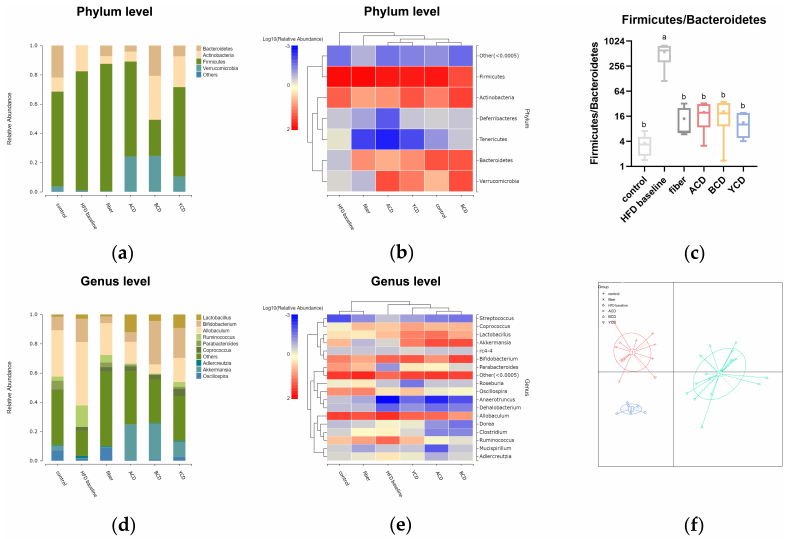
Figure 10. α -CD, β -CD, and γ -CD supplementation altered microbiota compositions. Fecal microbial community ( a , b ) at the phylum level and ( d , e ) at the genus level; ( c ) ratio of relative abundance of Firmicutes to Bacteroidetes; ( f ) enterotype clustering, n = 6. Control, low-fat diet; HFD baseline, high-fat diet without cellulose; fiber, high-fat diet; ACD, high-fat diet that replaced α -CD with cellulose; BCD, high-fat diet that replaced β -CD with cellulose; YCD, high-fat diet that replaced γ -CD with cellulose. Values not sharing a common superscript differ significantly among groups ( p < 0.05,